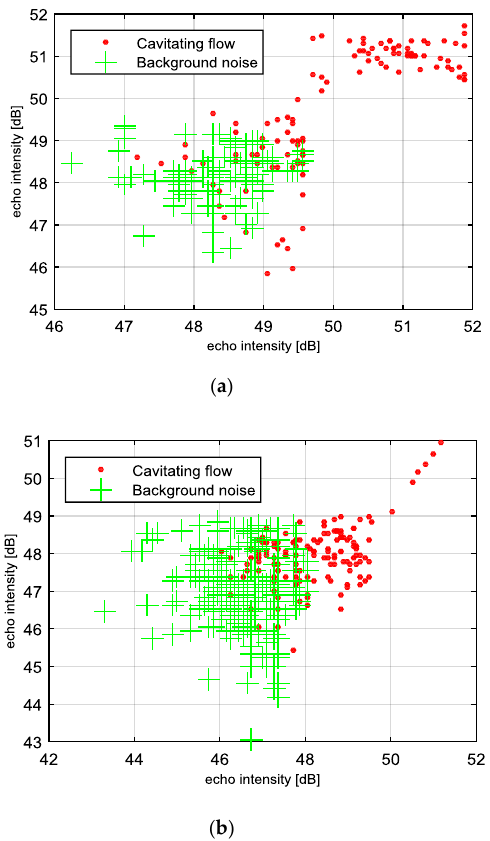
Figure 10. K-means clustering of echo intensity (acoustic backscattering intensity) data acquired using a DBS system for ( a ) propeller and ( b ) waterjet. Two clusters are shown, where green crosses represent background noise and red dots represent cavitating